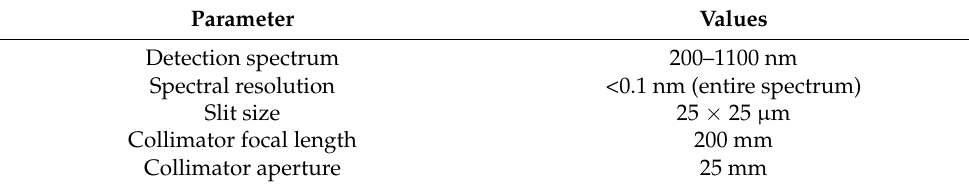
Table 1. Parameters of the designed system.